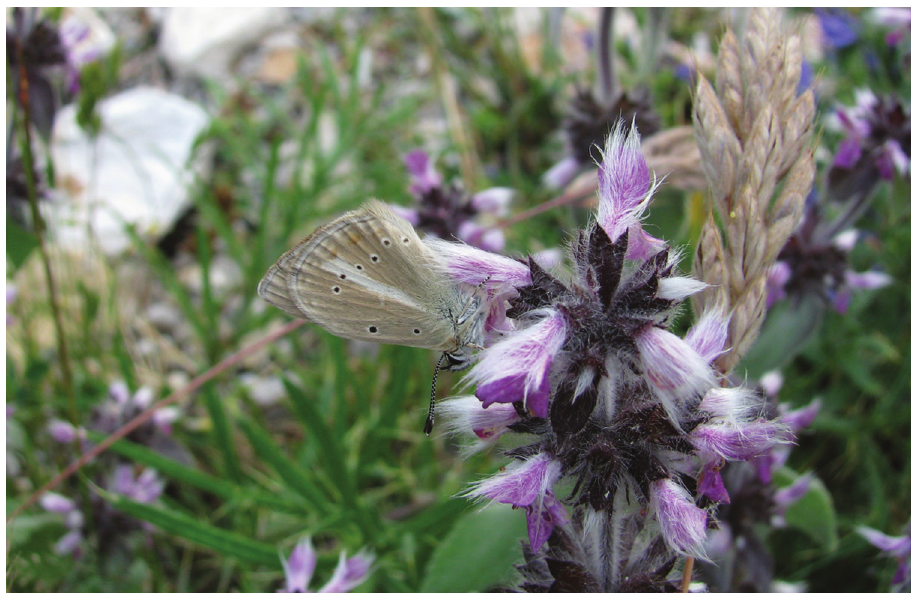
Figure 28. Polyommatus nephohiptamenos . Northern Greece, Falakro Mt, near Granitis, 1700 m, 23 July 2008. Photo by V.A. Lukhtanov.